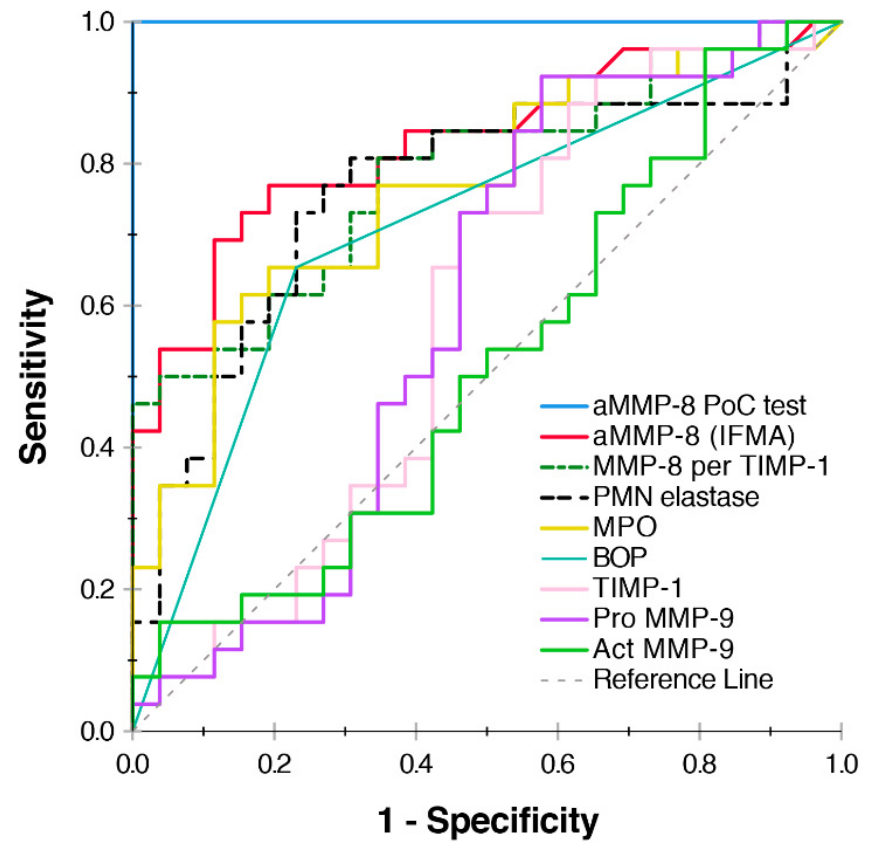
Figure 1. Receiver operating characteristic (ROC) analysis illustrating the diagnostic ability of the biomarker candidates to discriminate peri-implantitis from healthy implant (26 peri-implant and 26 healthy dental implant patients). aMMP-8 PoC test, IFMA, ELISA and gelatin-zymography for indicated biomarkers and bleeding on probing (BOP) were assessed as described previously [7,12,26,27].